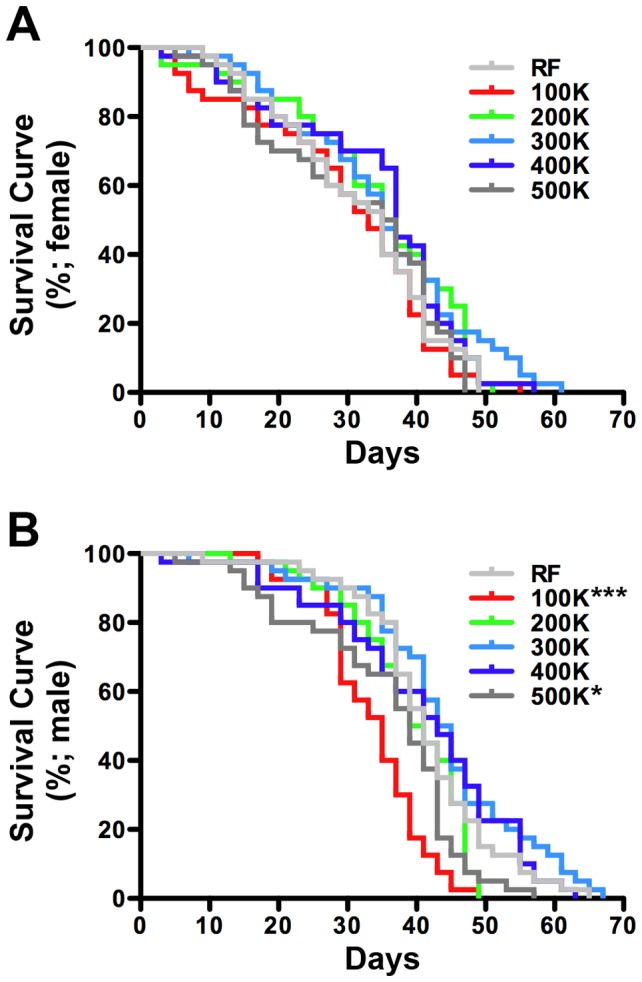
The effect of CDF on adult survival.(A) Survival of adult female flies cultured on chemically defined food as a function of caloric density. Comparison of all survival curves by long-rank (Mantel-Cox) test shows no statistical difference (n = 40; p≥0.1053 for all). (B) Survival of adult male flies cultured on chemically defined food as a function of caloric density. Paired comparison of survival curves between RF to other CDFs shows that the life span of males is only significantly reduced on 100 K-cal/L CDF (n = 40; p<0.0001) and slightly reduced on 500 K-cal/L CDF (n = 40, p = 0.0489). See Table S1 for additional details.